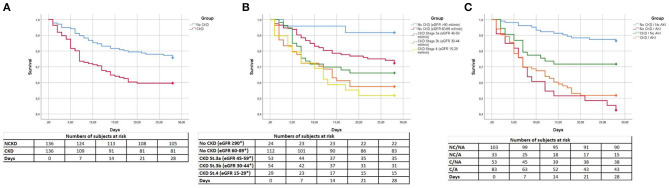
Cumulative Kaplan–Meier survival estimates of the time to patient death. (A) Comparison of CKD vs. non-CKD patients. CKD, chronic kidney disease; NCKD, non-chronic kidney disease. (B) Comparison of stages of CKD severity. *mL/min/1.73m2. St, stage. (C) Comparison of CKD and non-CKD patients with and without acute kidney injury. A, acute kidney injury, C, chronic kidney disease, NA, no acute kidney injury. NC, non-chronic kidney disease.